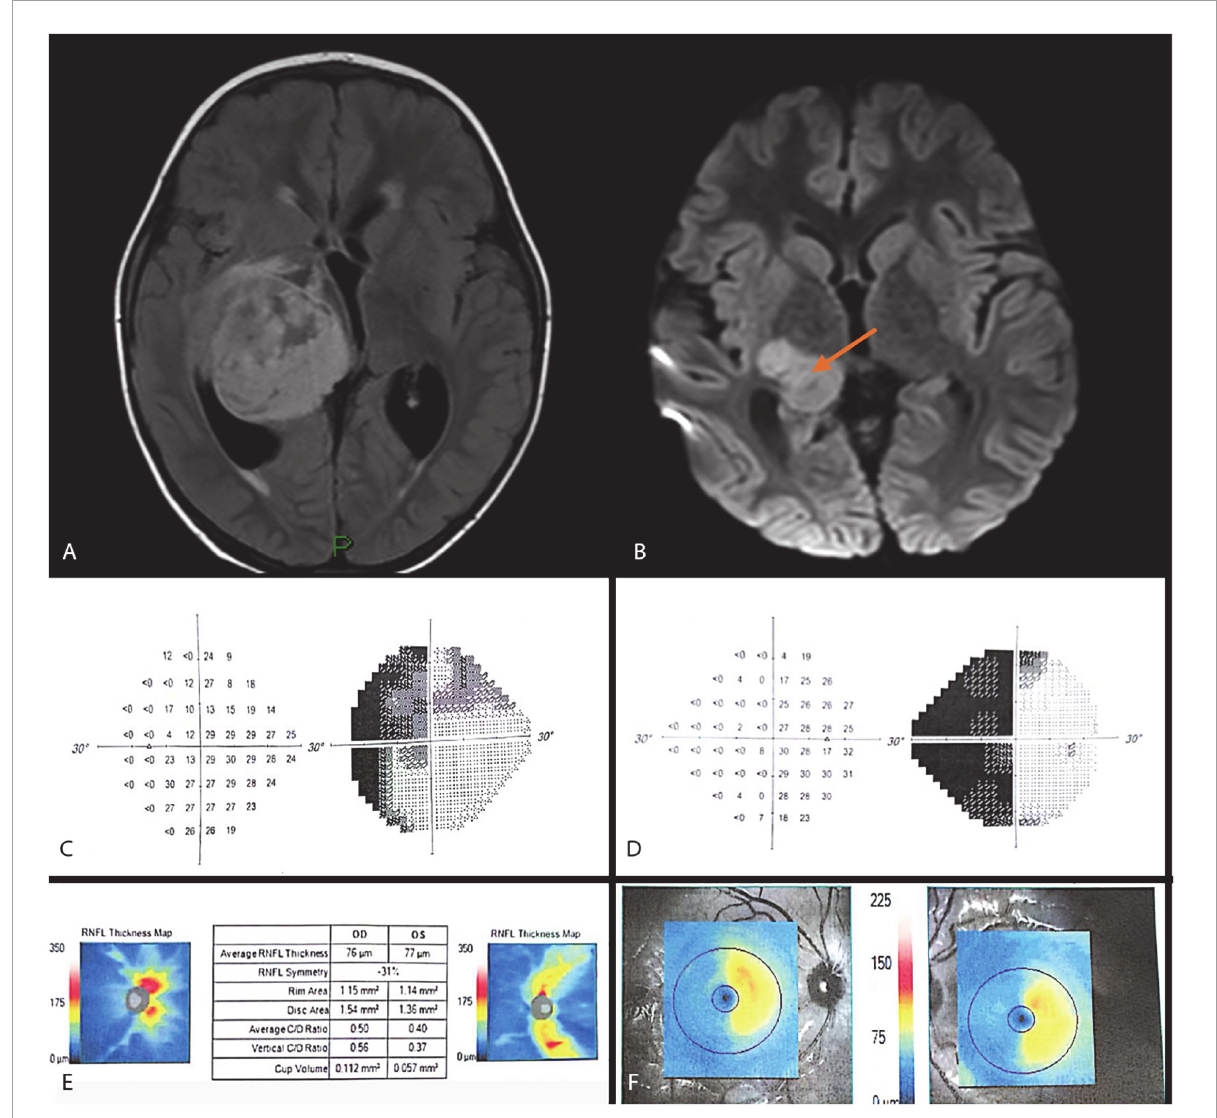
FIGURE3 Case 3. MRI FLAIR and DWI images (A,B) show a right thalamic lesion extending to the right optic radiation causing significant mass effect and hydrocephalus. Automated perimetry at 12 months after surgery showing left homonymous hemianopia (C,D) . OCT 6 months after surgery showing RNFL thinning in the right superior and inferior and left nasal and temporal quadrants (E), and related retinal ganglion cell counts (F) .